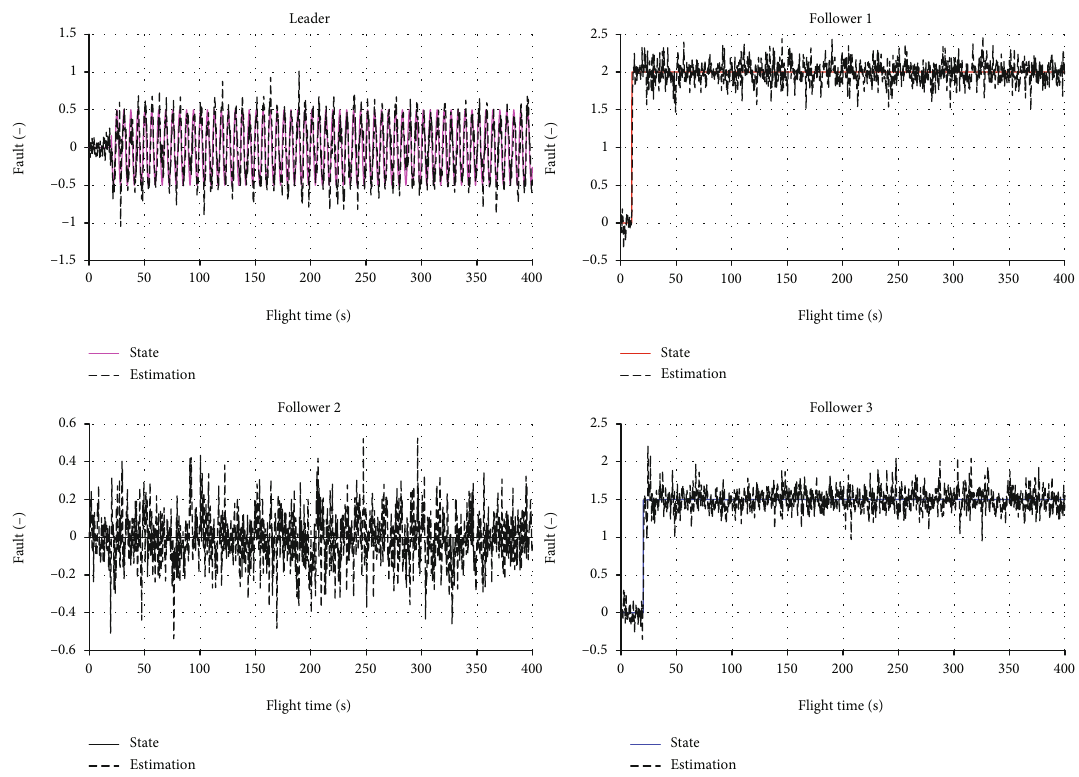
Figure 15: The faults and estimations for the UAV formation (with wind).